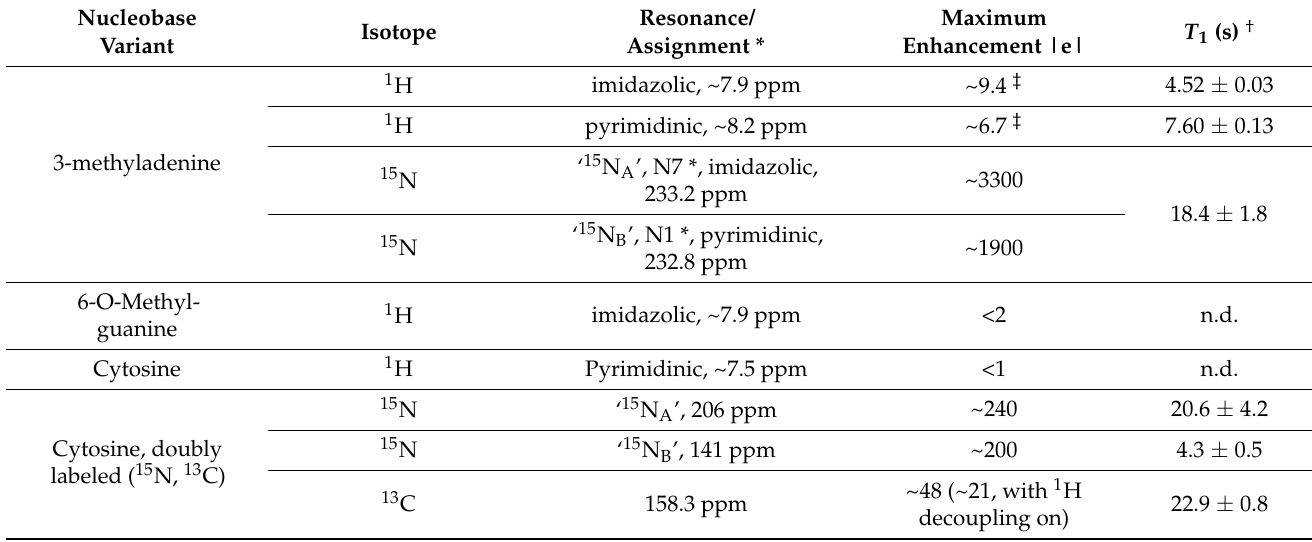
Table 1. Summary of nucleobase SABRE enhancements and T 1